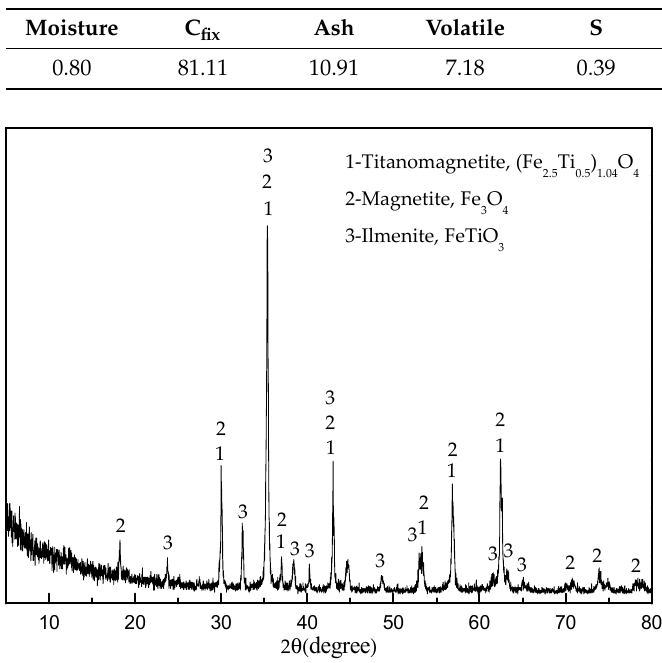
Table 3. Proximate analysis of the coal (air dry, wt %).